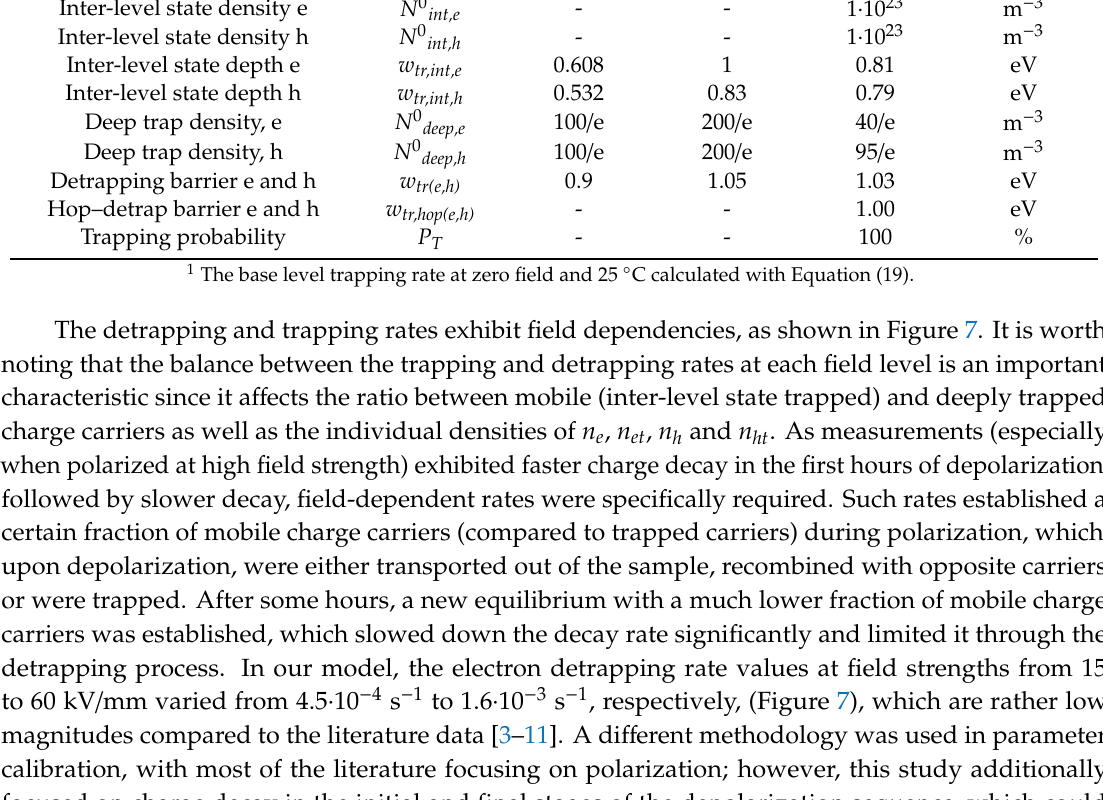
Table 4. Ranges of trapping and detrapping parameters from [3–11] and values used in the model. Description